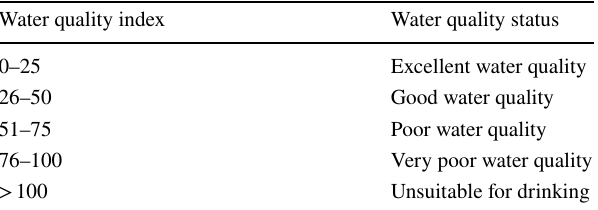
Table 4 Water quality index (WQI) and status of water quality status Water quality